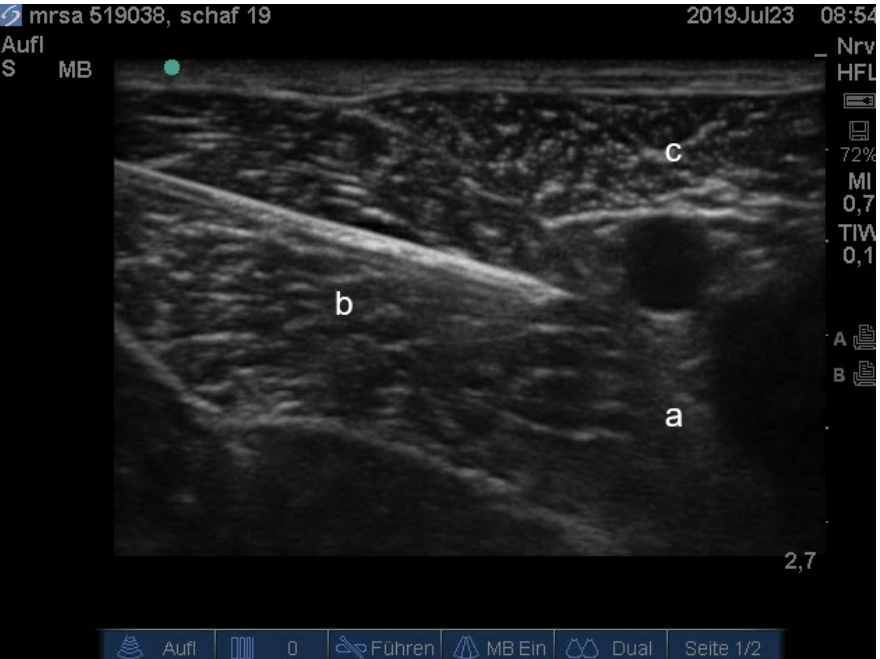
Figure 2. Ultrasonographic image of the left femoral nerve, femoral artery and vein (a), needle (b) and sartorius muscle (c).